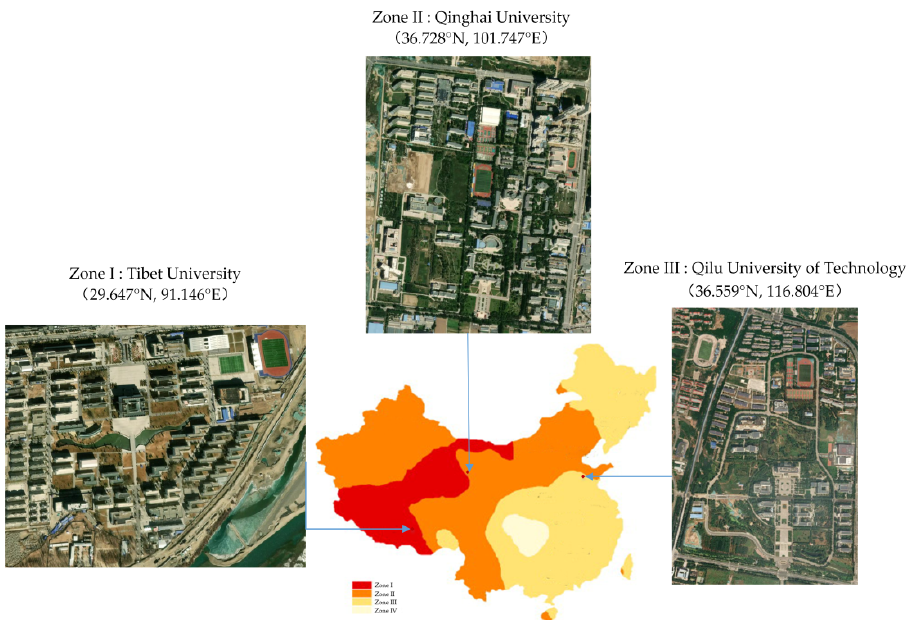
Figure 4. Location and satellite images of Tibet University, Qinghai University, and Qilu University of Technology.